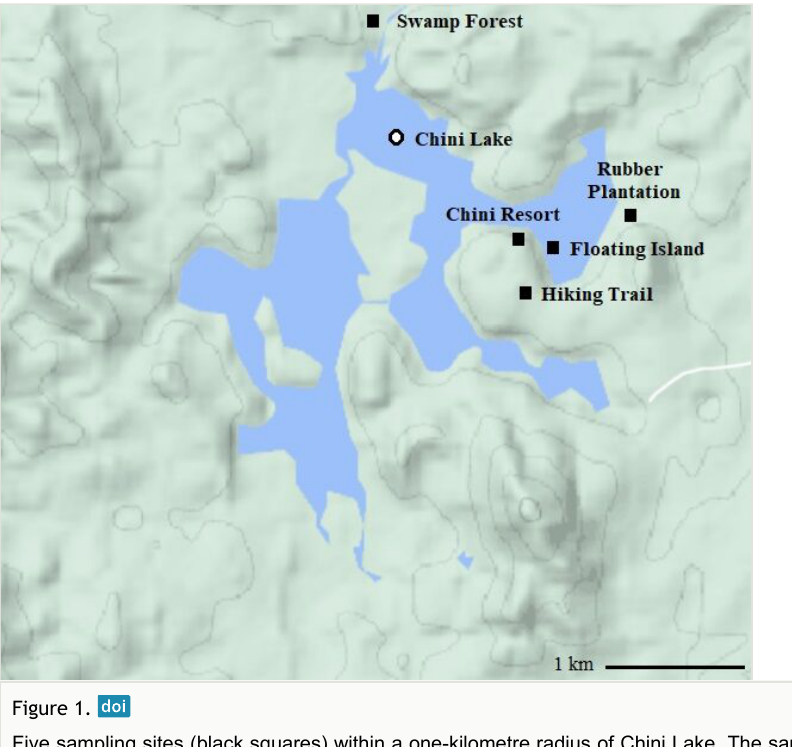
Five sampling sites (black squares) within a one-kilometre radius of Chini Lake. The sampling sites are situated at an accessible section of the Lake. The light blue denotes the water body of Chini Lake and the different shades of green denote the contour of the land around the